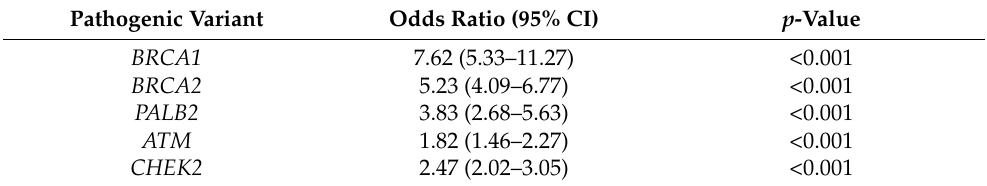
Table 1. Associations between pathogenic variants in established breast-cancer-predisposition genes and risk of breast cancer.